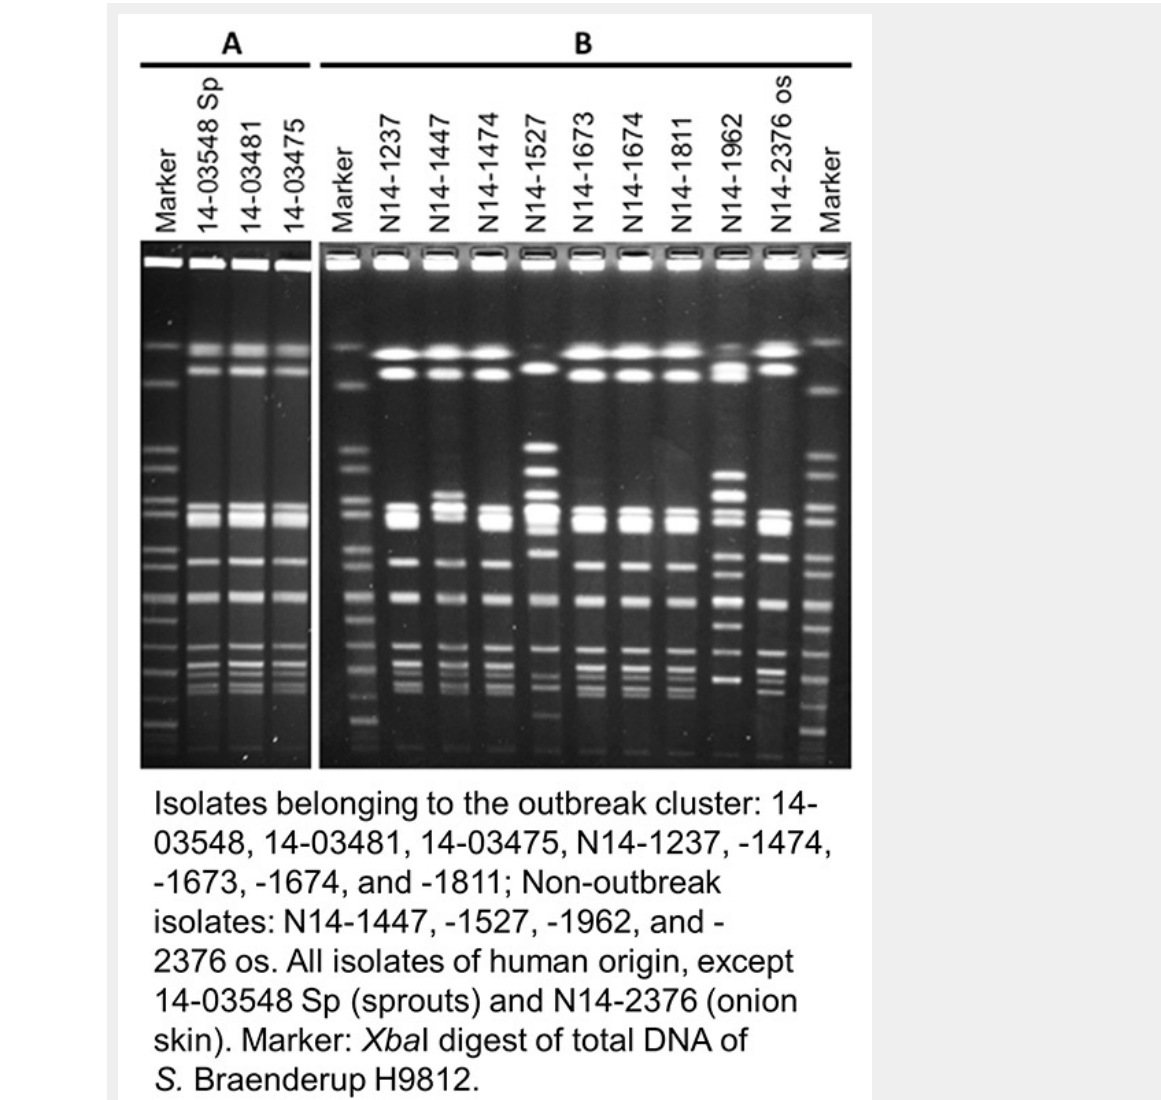
Figure 3 Pulsed-field gel electrophoresis (PFGE) profiles of selected Salmonella Bovismorbificans isolates from Germany (A) and Switzerland